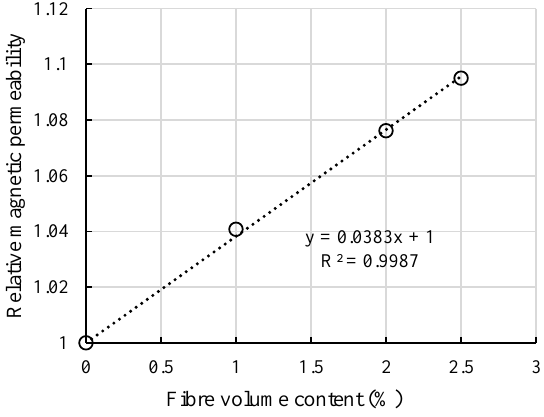
Figure 8. Relationship between fibre volume content and relative magnetic permeability.